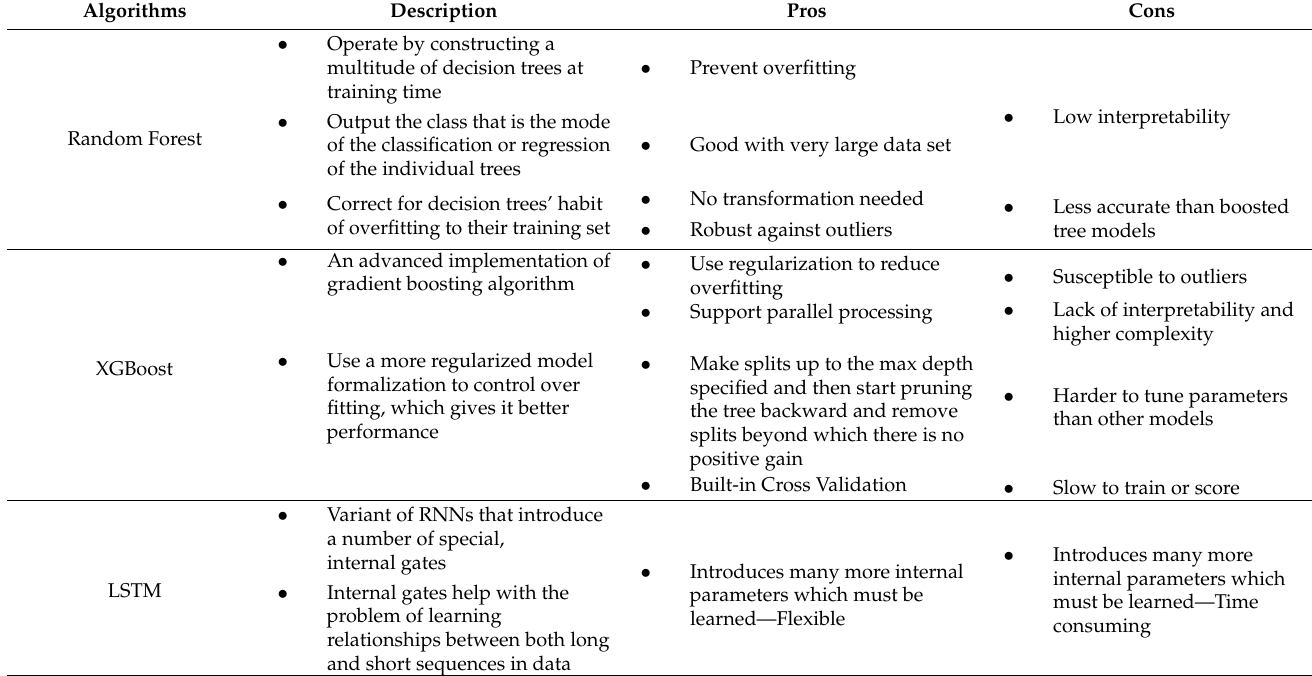
Table 2. Attributes of the algorithms.